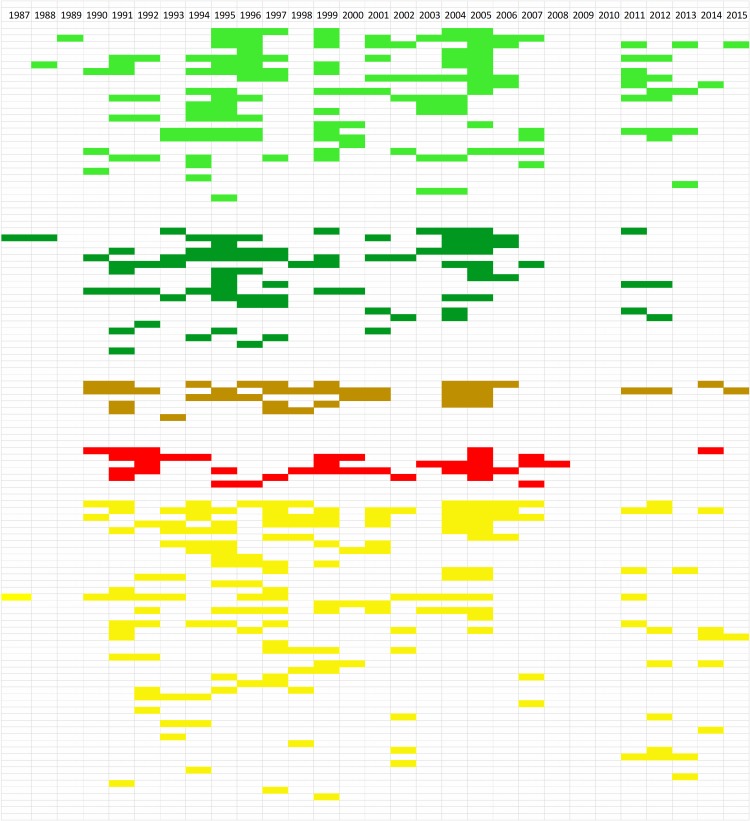
Persistence of emm types.Each row with colours blocks is an emm type. The top row is calendar year. A block is coloured if there was at least one of that emm type isolated in that year. Pale green: vaccine types; dark green: cross opsonisation-positive, brown: cross opsonisation-equivocal; red: cross opsonisation-negative; yellow: cross opsonisation-unknown. The Excel file from which this is derived, containing emm type numerical information, is provided as S5 Dataset.